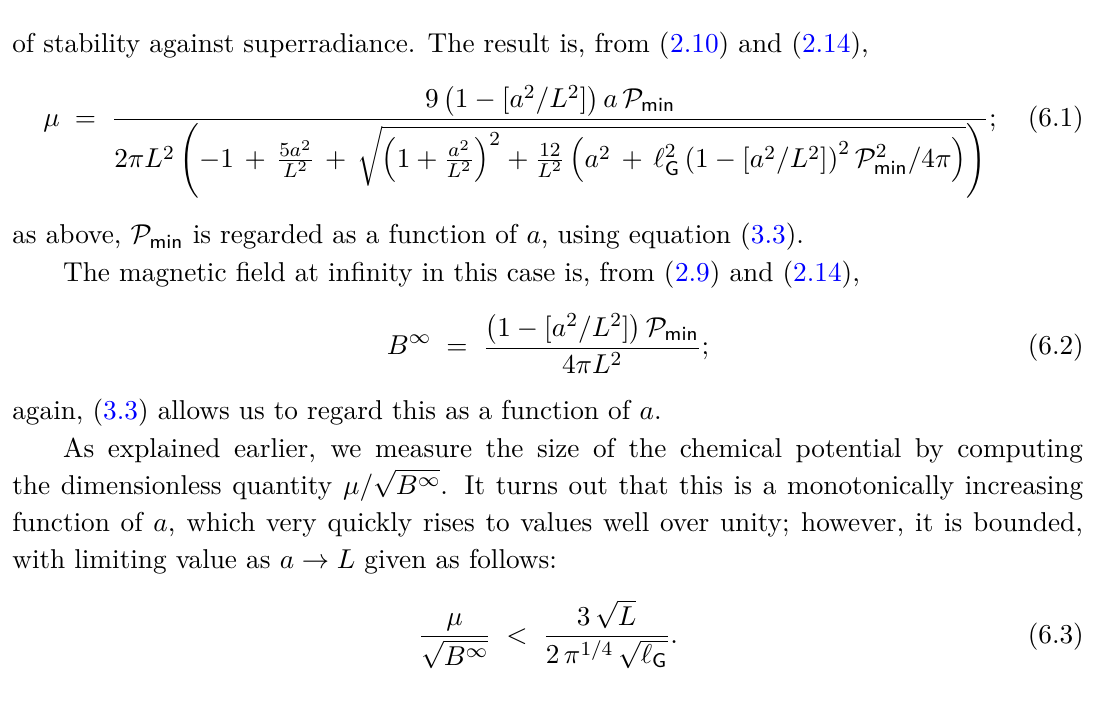
Figure 6 . The value of θ which gives the position, on the event horizon, where the induced electric field is maximal, for an extremal AdS 4 -Kerr-Newman magnetic black hole with L = 100 , as a function of a . (Units are Planck units; bear in mind that, for a/L < 1 / 3 , the maximal field occurs at θ = 0